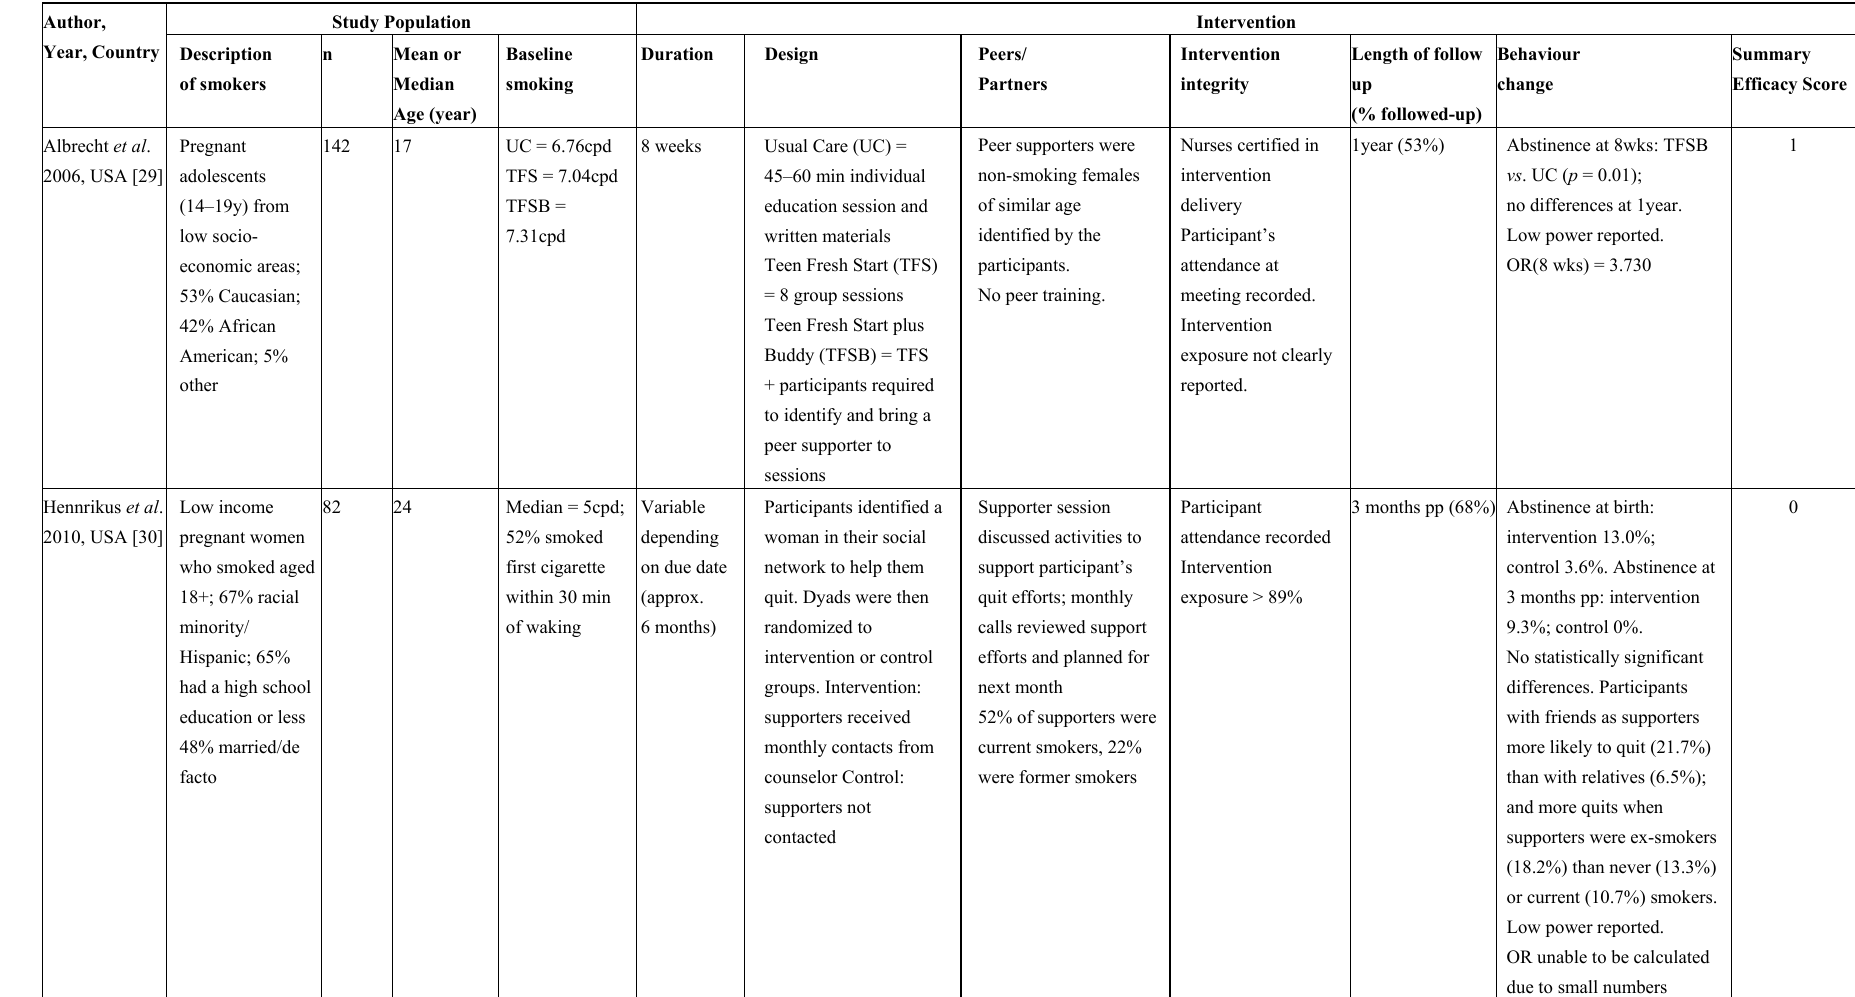
Table 1. Characteristics of the included evaluations of peer support smoking